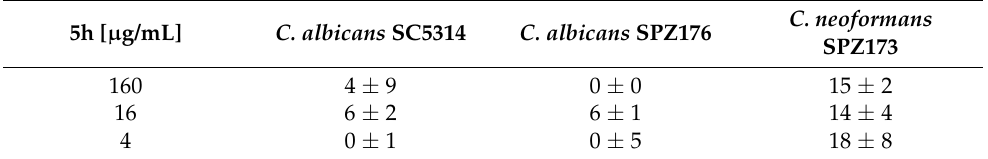
Table 7. Decrease of rhodamine content [ ∆ C% ±